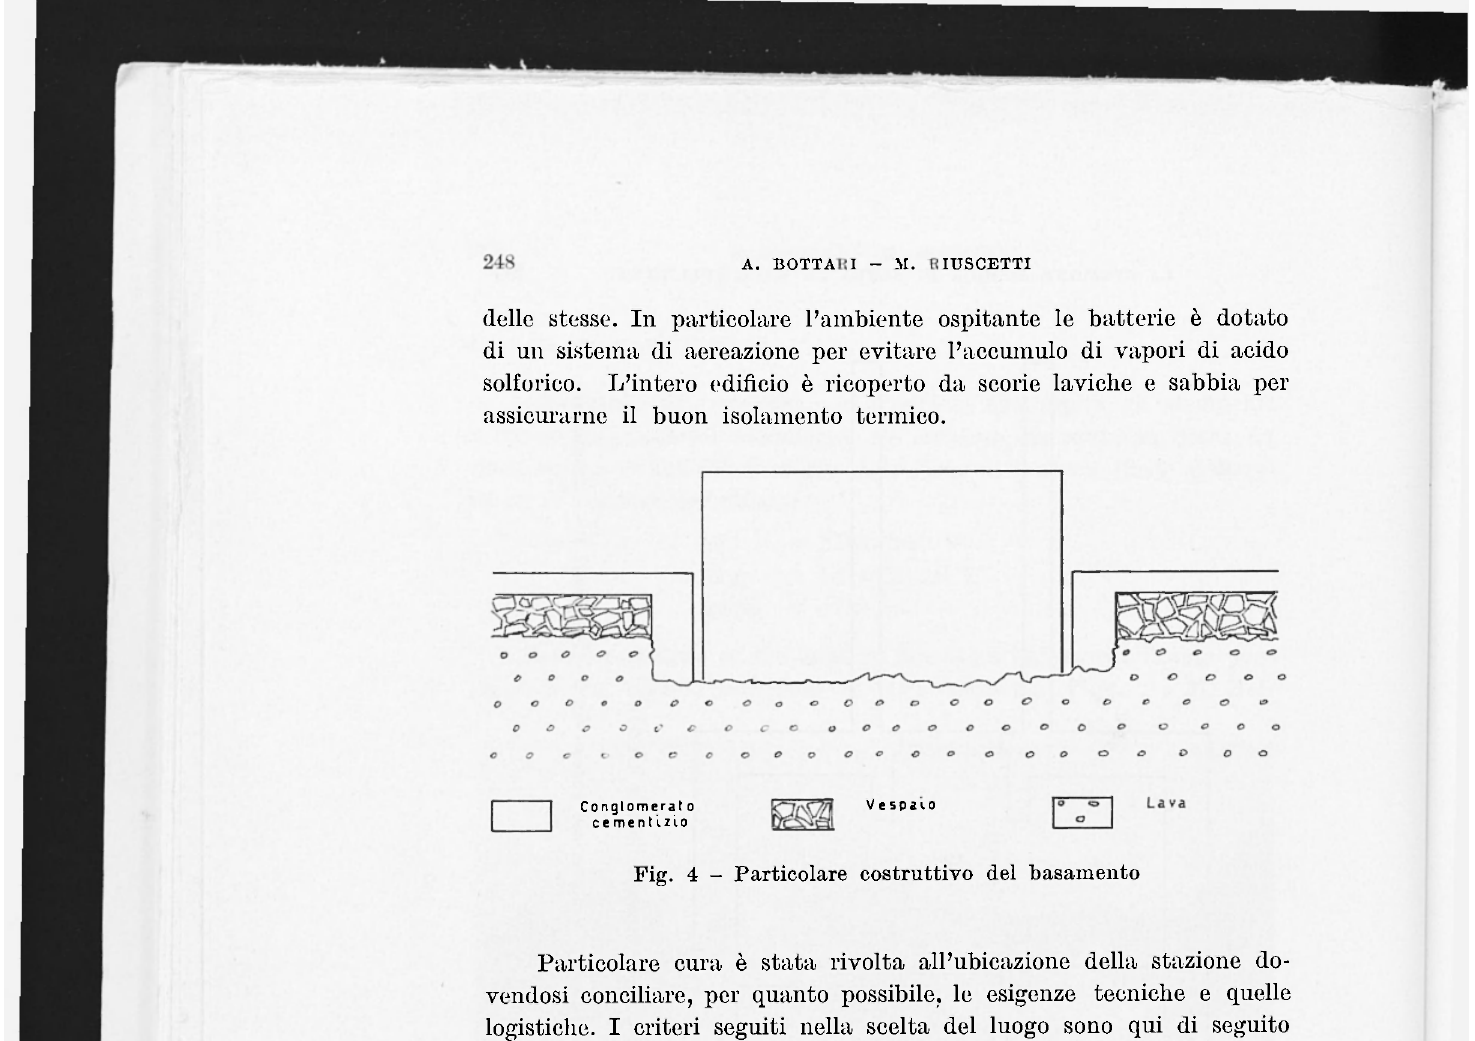
Fig. 4 - Particolare costruttivo del